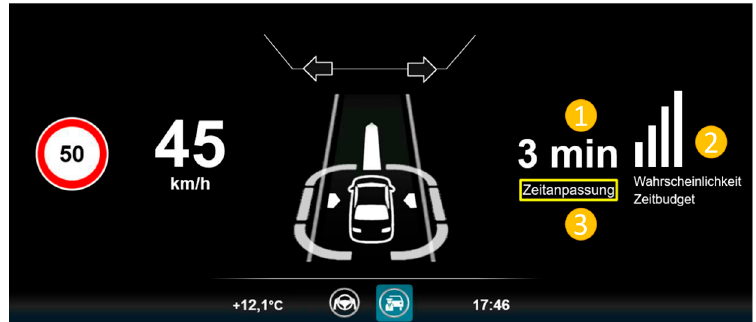
Figure 2. Visualization of the advanced HMI including: time budget ( 1 ); confidence level ( 2 ); and message time budget adjustment ( 3 ).